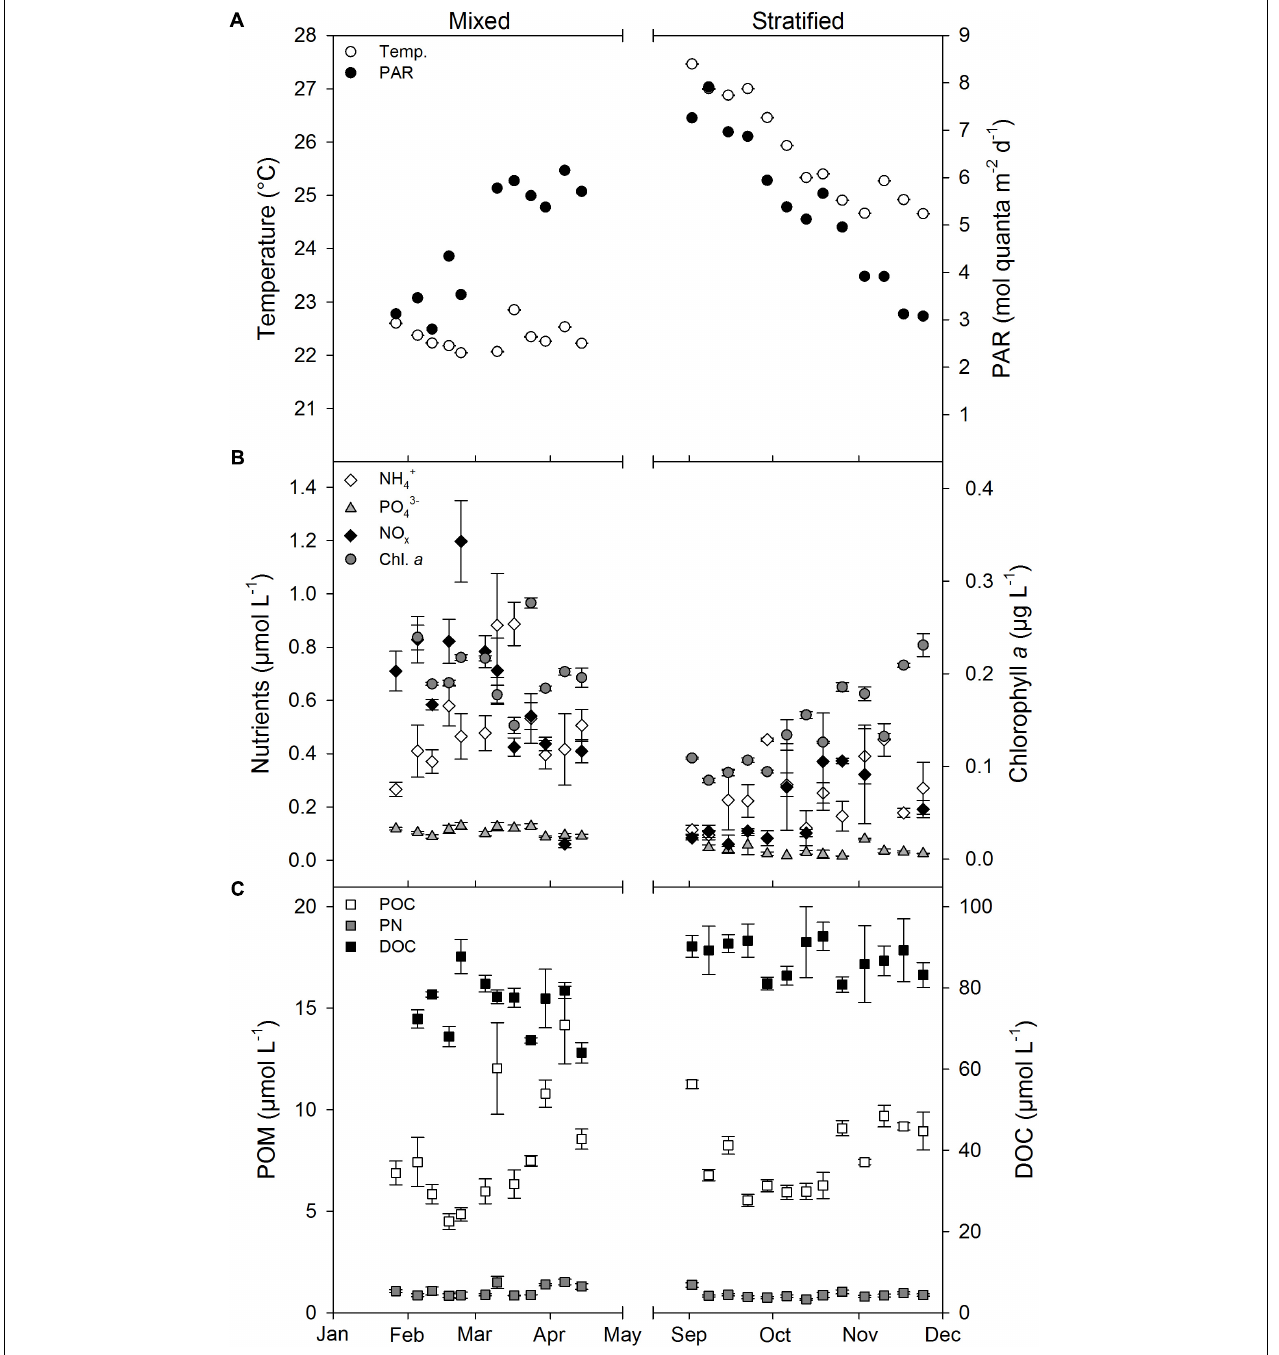
FIGURE 1 | Mean weekly environmental water parameters measured at 10 m water depth (1 m over coral reef benthos) during the mixed and stratified periods. (A) Temperature and PAR. (B) Nutrients and chlorophyll a . (C) POM and DOC. Values given as mean ± SE. Temp, water temperature; PAR, photosynthetically active radiation measured at 10 m water depth; NO x , NO 2 − + NO 3 − ; POC, particulate organic carbon; PN, particulate nitrogen; POM, particulate organic matter (POC and PN); DOC, dissolved organic